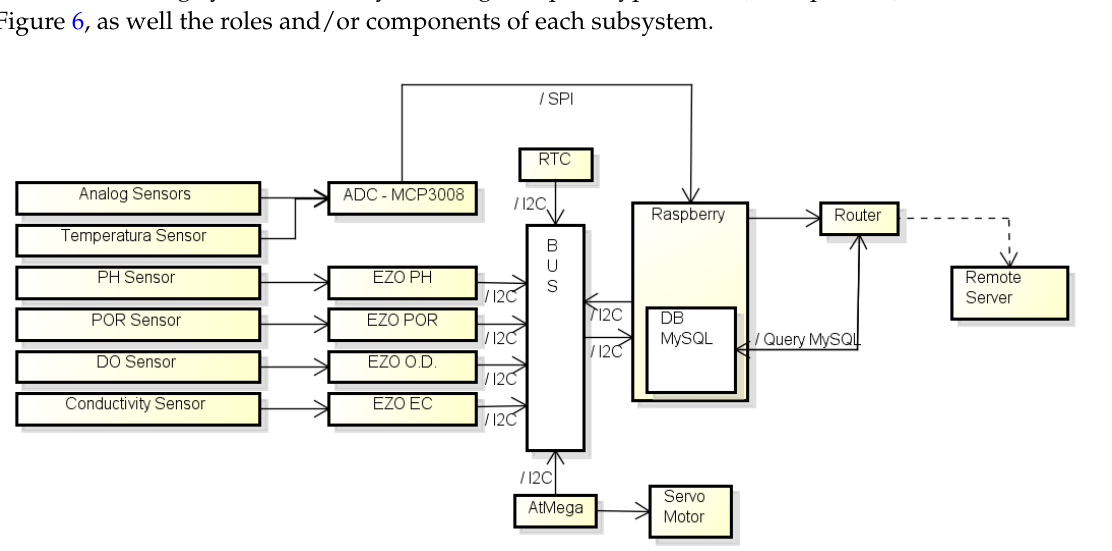
Figure 7. System architecture with used communication